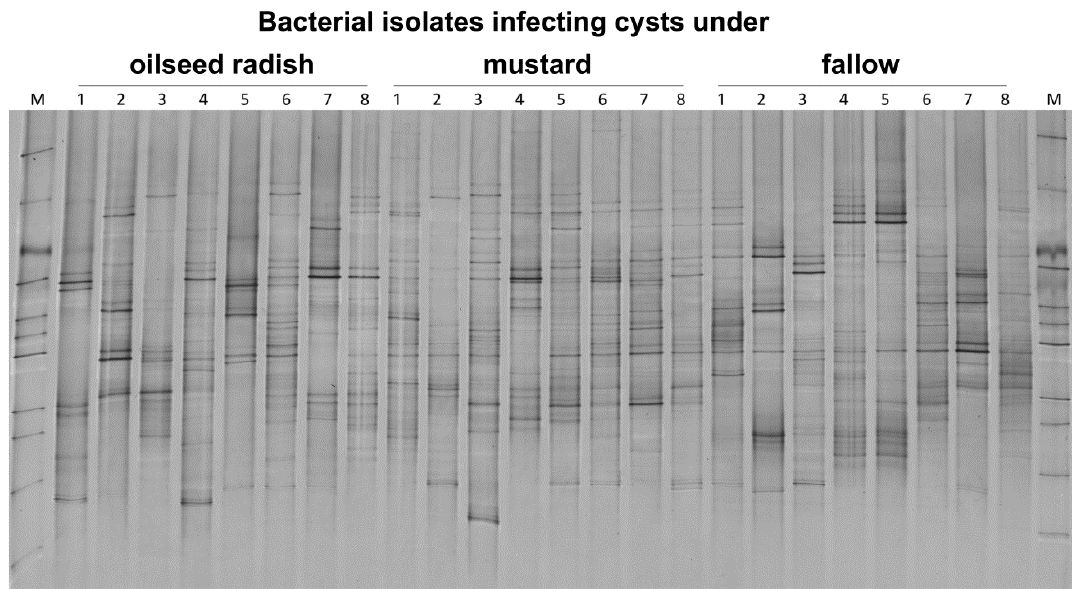
Figure 5. Gross Munzel, DGGE fingerprints of 16S rRNA gene fragments amplified from the DNA of 10 pooled cysts per replicate sample (the number above each lane refers to the replicate number for each treatment) from three cover crop treatments in the year prior to the sugar beet production. M: Marker including the 16S rRNA fragments of bacterial isolates.